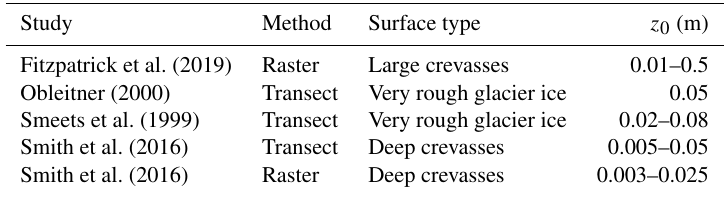
Table 1. Published aerodynamic roughness length values for crevassed glacier